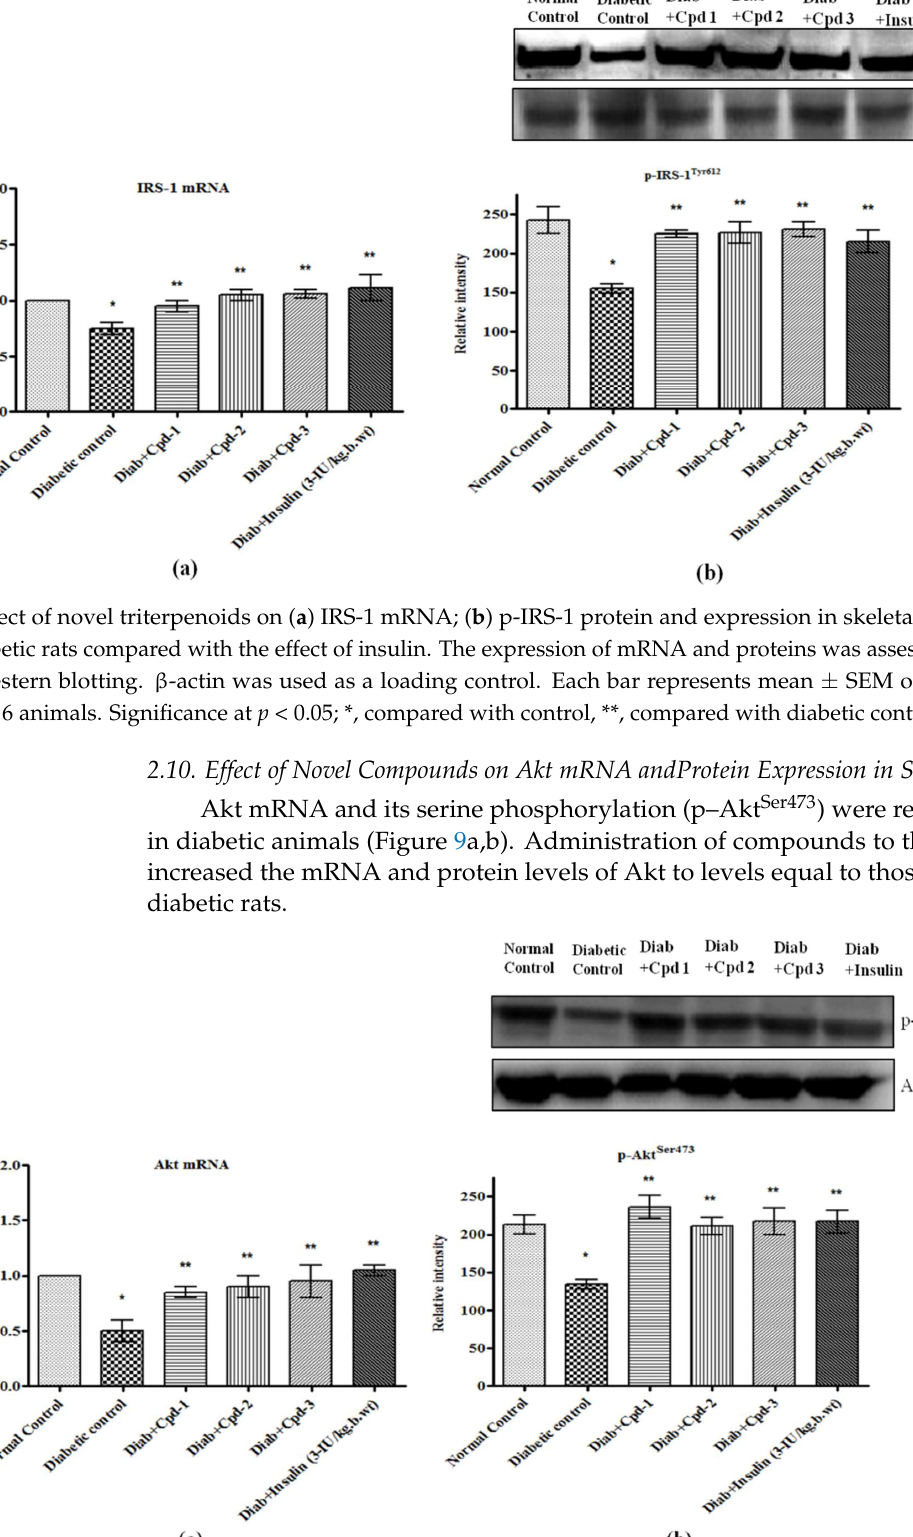
Figure 10. Effect of novel triterpenoids on ( a ) GLUT4 mRNA; ( b ) protein expression in skeletal muscle of STZ-induced diabetic rats compared with the effect of insulin. The expression of mRNA and proteins was assessed by real-time PCR and Western blotting. β-actin was used as a loading control. Each bar represents mean ± SEM of 3 observations represent- ing 6 animals. Significance at p < 0.05; *, compared with control, **, compared with diabetic control.